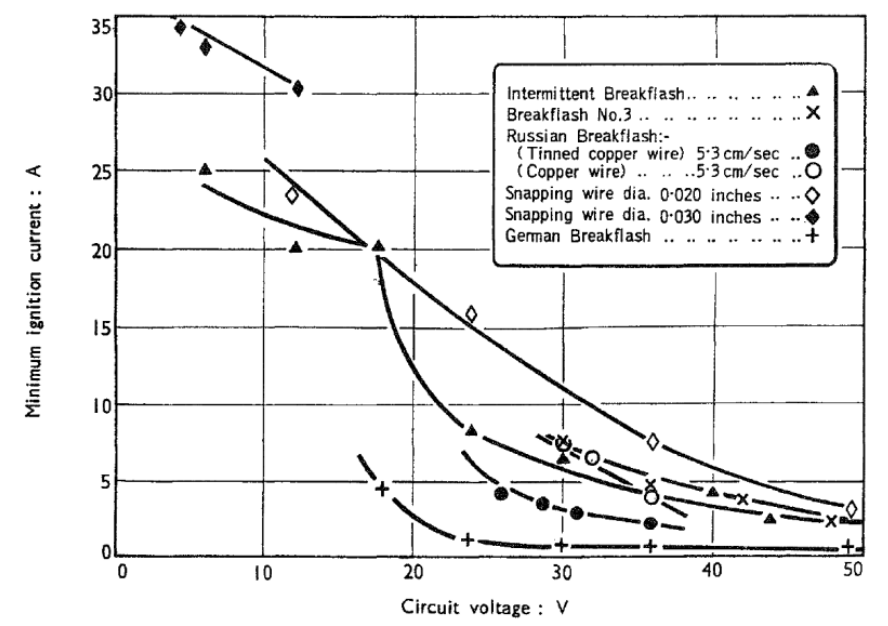
Figure 7. Effect of apparatus differences on the I–V relationship for the ignition of 8.3% methane atmospheres in a resistive circuit (Widginton [48]).